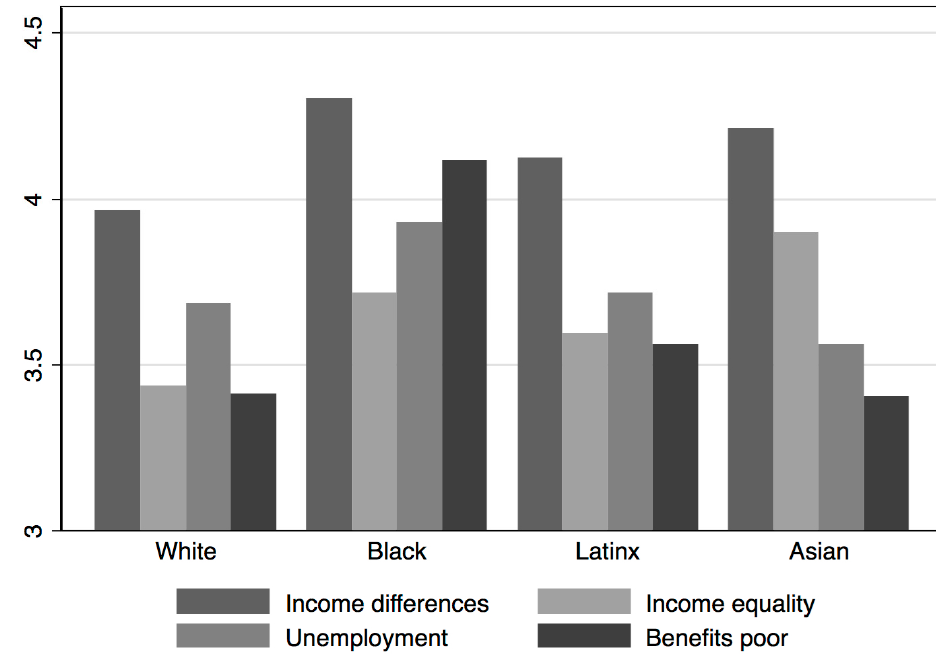
Figure 3. Support for redistribution by race/ethnicity (Index 1 questions).